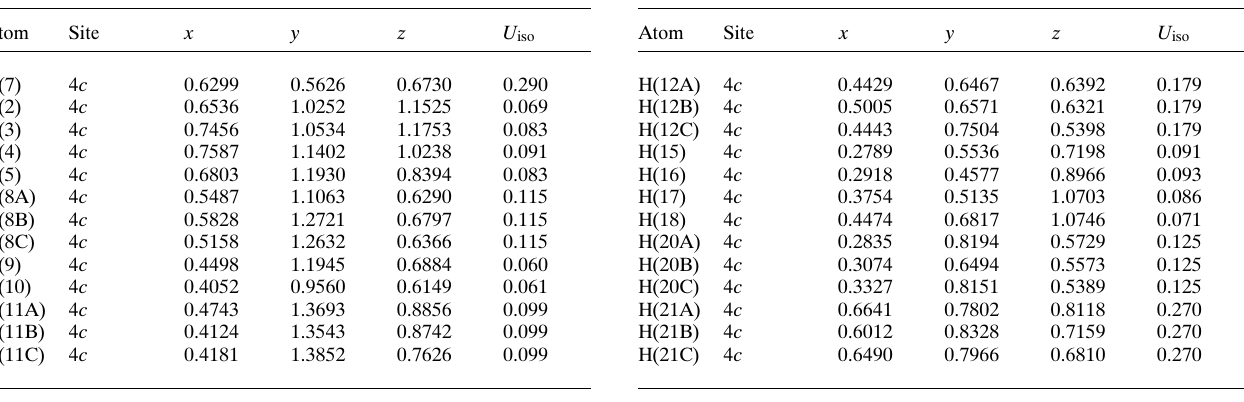
Table 2. Atomic coordinates and displacement parameters (in Å 2 ) . Table 2. Continued